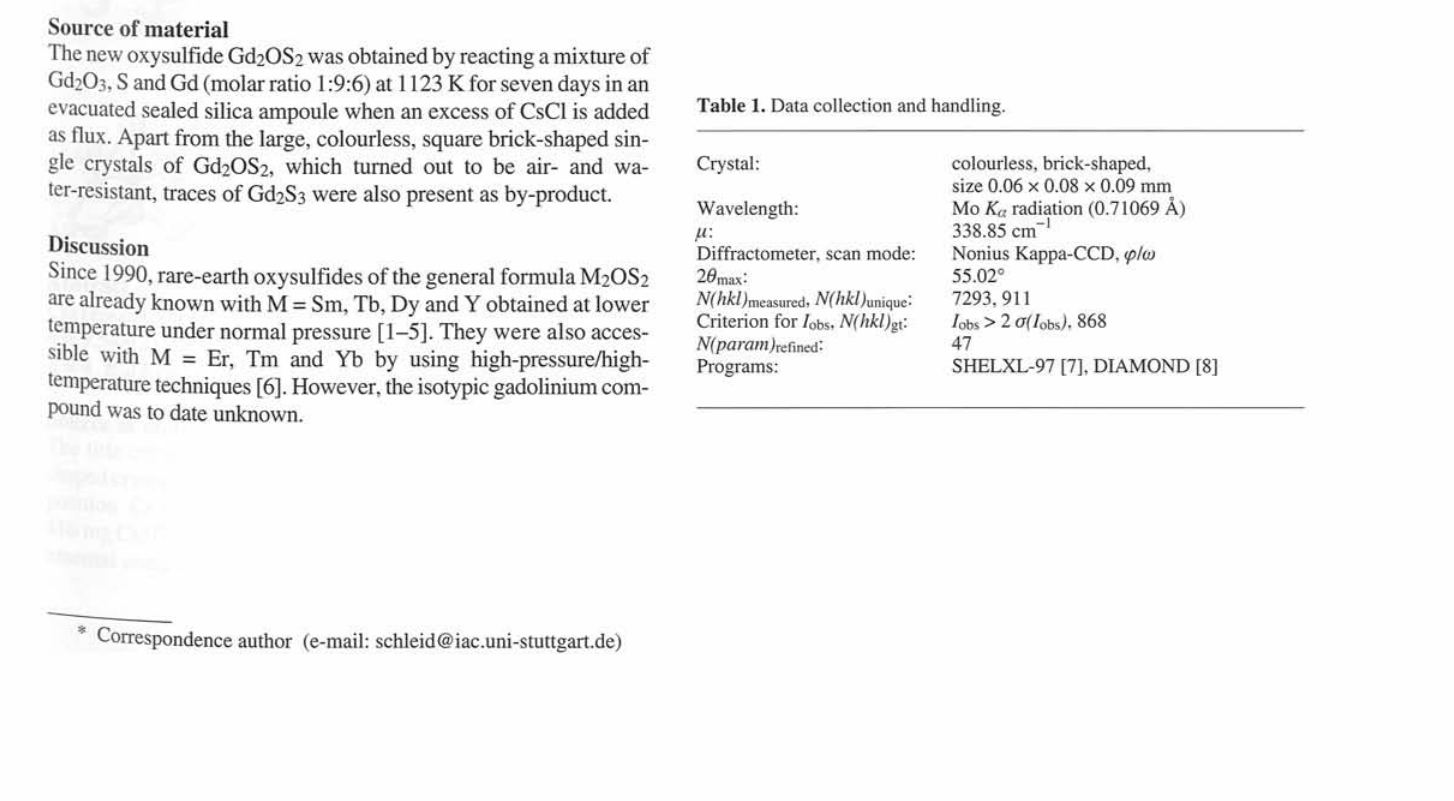
Table 1. Data collection and